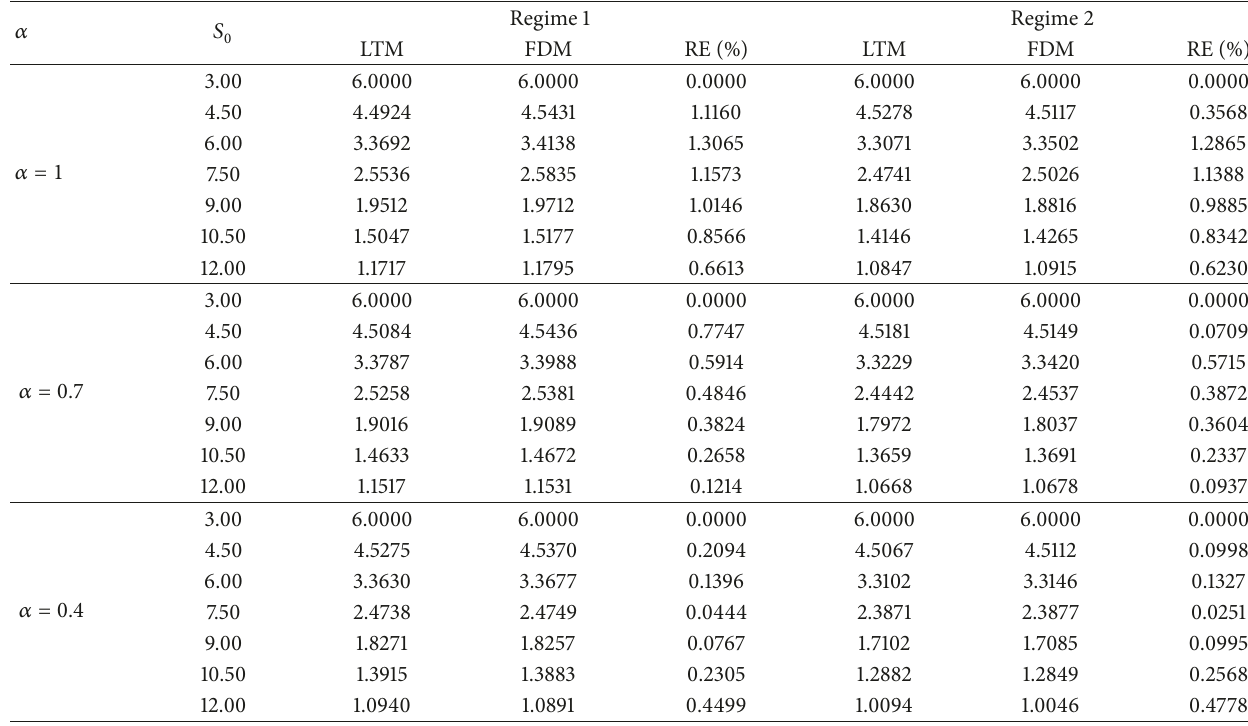
Table 1: Prices of American put option with parameters 𝜎 1 = 0.8, 𝜎 2 = 0.3, 𝑟 1 = 0.1, 𝑟 2 = 0.05, 𝑞 1 = 6, 𝑞 2 = 9, 𝐾 = 9, 𝑇 = 1 and different values of 𝛼